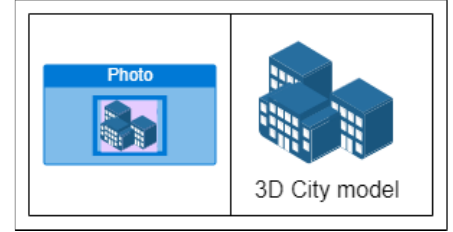
Figure 1. Conceptual model of the dual-window system